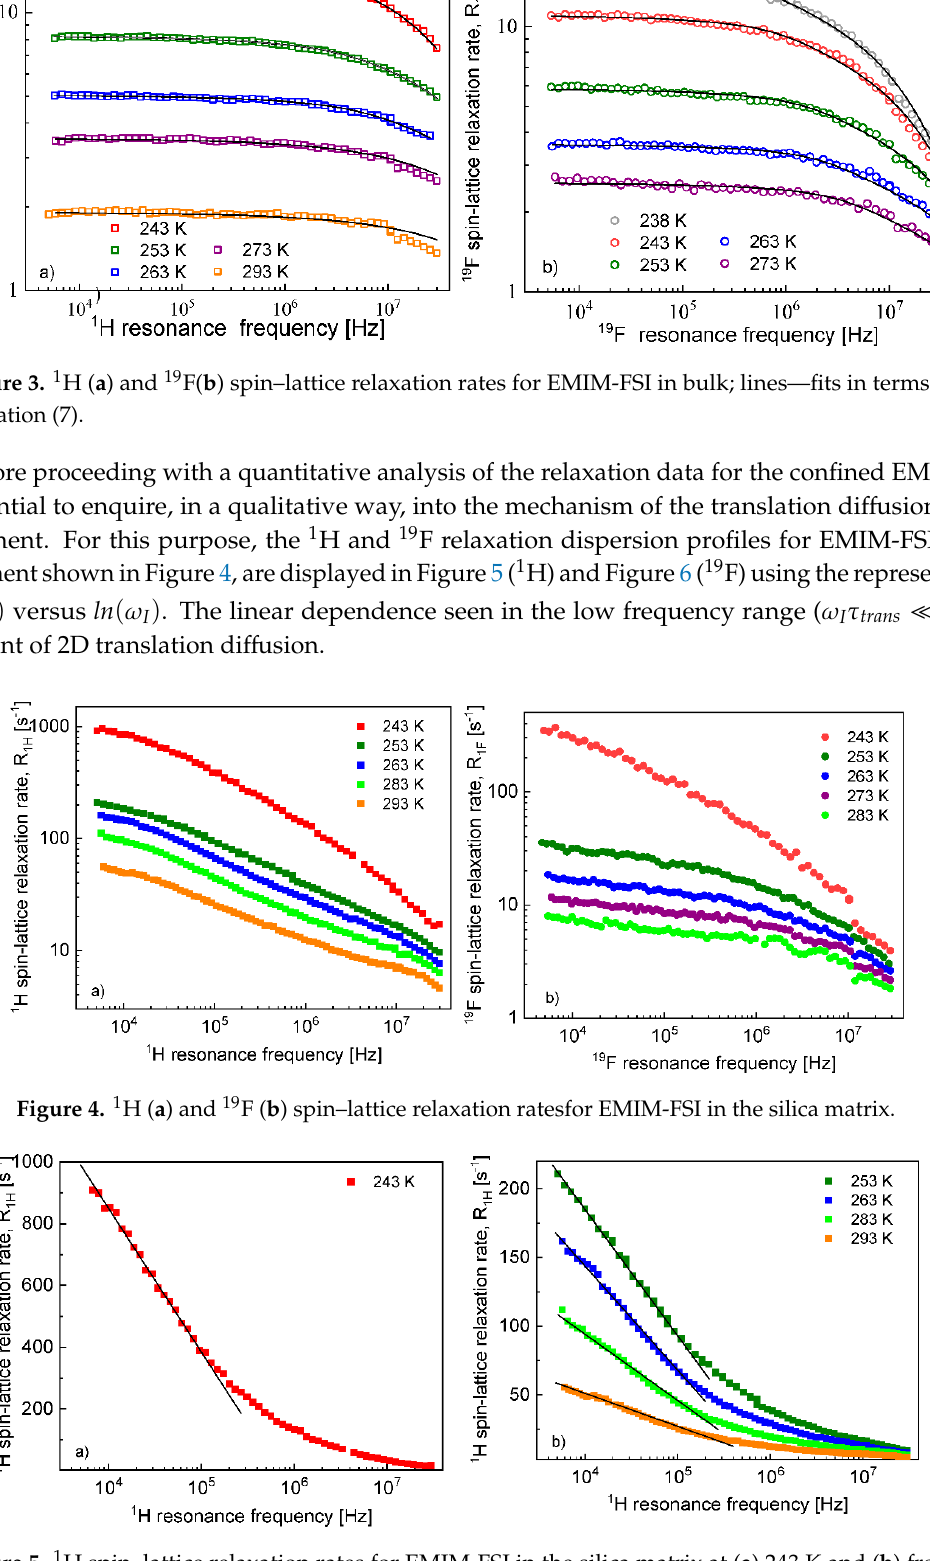
Figure 6. 19 F spin–lattice relaxation rates for EMIM-FSI in the silica matrix at ( a ) 243 K and ( b ) from 253 K to 283 K; lines—linear dependencies characteristic of 2D translation diffusion. On this basis, the 1 H and 19 F spin–lattice relaxation data for EMIM-FSI in the confinement were fitted in terms of Equation (8) with the adjustable parameters: 𝐶 𝐷𝐷,𝐼𝑡𝑟𝑎𝑛𝑠,𝑐𝑜𝑛𝑓 , 𝜏 𝑡𝑟𝑎𝑛𝑠𝑐𝑜𝑛𝑓 , 𝐶 𝐷𝐷,𝐼𝑟𝑜𝑡,𝑐𝑜𝑛𝑓,𝑠 , 𝜏 𝑟𝑜𝑡,𝐼𝑐𝑜𝑛𝑓,𝑠 , 𝐶 𝐷𝐷,𝐼𝑟𝑜𝑡,𝑐𝑜𝑛𝑓,𝑓 ,𝜏 𝑟𝑜𝑡,𝐼𝑐𝑜𝑛𝑓,𝑓 ,𝐴 𝐼 .To directly refer tothe cation and the anion dynamics, it is convenient to rename the parameters as 𝐶 𝑡𝑟𝑎𝑛𝑠 𝑐𝑎𝑡𝑖𝑜𝑛 , 𝜏 𝑡𝑟𝑎𝑛𝑠,𝑐𝑜𝑛𝑓𝑐𝑎𝑡𝑖𝑜𝑛 , 𝐶 𝐷𝐷,𝑐𝑜𝑛𝑓𝑐𝑎𝑡𝑖𝑜𝑛,𝑠 , 𝜏 𝑟𝑜𝑡,𝑐𝑜𝑛𝑓𝑐𝑎𝑡𝑖𝑜𝑛,𝑠 , 𝐶 𝐷𝐷,𝑐𝑜𝑛𝑓𝑐𝑎𝑡𝑖𝑜𝑛,𝑓 ,𝜏 𝑟𝑜𝑡,𝑐𝑜𝑛𝑓𝑐𝑎𝑡𝑖𝑜𝑛,𝑓 ,𝐴 𝑐 for 1 H and 𝐶 𝑡𝑟𝑎𝑛𝑠 𝑎𝑛𝑖𝑜𝑛 , 𝜏 𝑡𝑟𝑎𝑛𝑠,𝑐𝑜𝑛𝑓𝑎𝑛𝑖𝑜𝑛 , 𝐶 𝐷𝐷,𝑐𝑜𝑛𝑓𝑎𝑛𝑖𝑜𝑛,𝑠 , 𝜏 𝑟𝑜𝑡,𝑐𝑜𝑛𝑓𝑎𝑛𝑖𝑜𝑛,𝑠 , 𝐶 𝐷𝐷,𝑐𝑜𝑛𝑓𝑎𝑛𝑖𝑜𝑛,𝑓 , 𝜏 𝑟𝑜𝑡,𝑐𝑜𝑛𝑓𝑎𝑛𝑖𝑜𝑛,𝑓 ,𝐴 𝑎 for 19 F. The obtained parameters are collected in